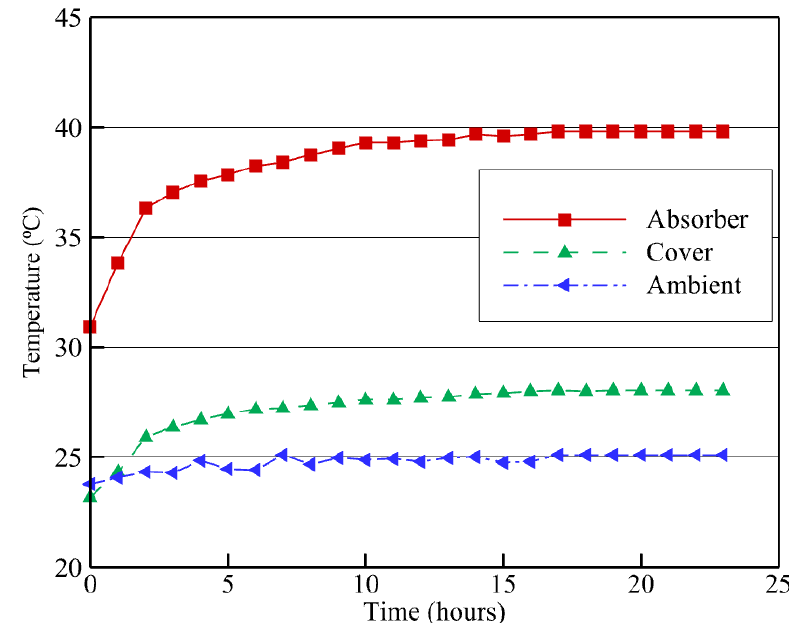
Figure 6. Experimental temperature development to steady-state.